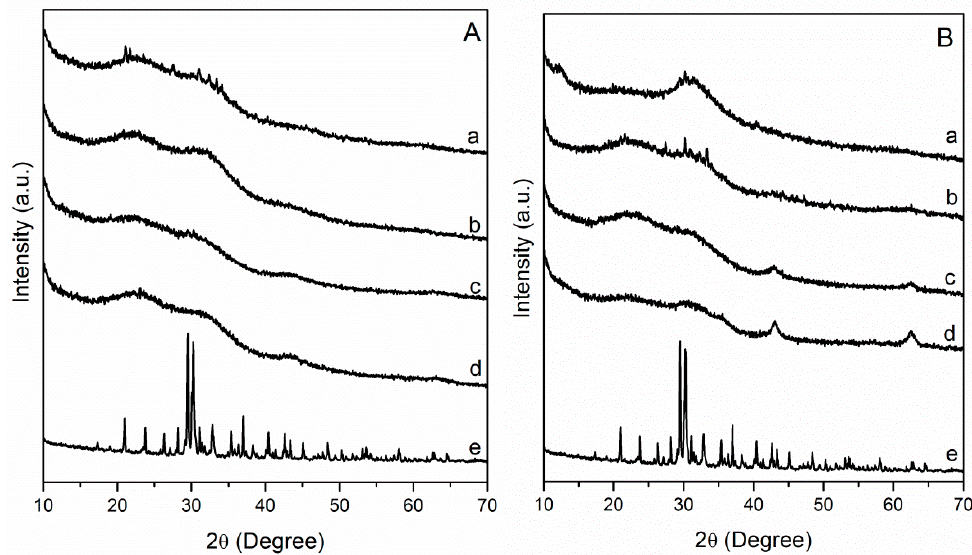
Figure 2. PXRD data of milled samples (9 h, 450 rpm) ( A ): MgAl 200 /K 2 HPO 4 (a), MgAl 300 /K 2 HPO 4 (b), MgAl 400 /K 2 HPO 4 (c), MgAl 500 /K 2 HPO 4 (d), K 2 HPO 4 (e); and ( B ): MgFe 200 /K 2 HPO 4 (a), MgFe 300 /K 2 HPO 4